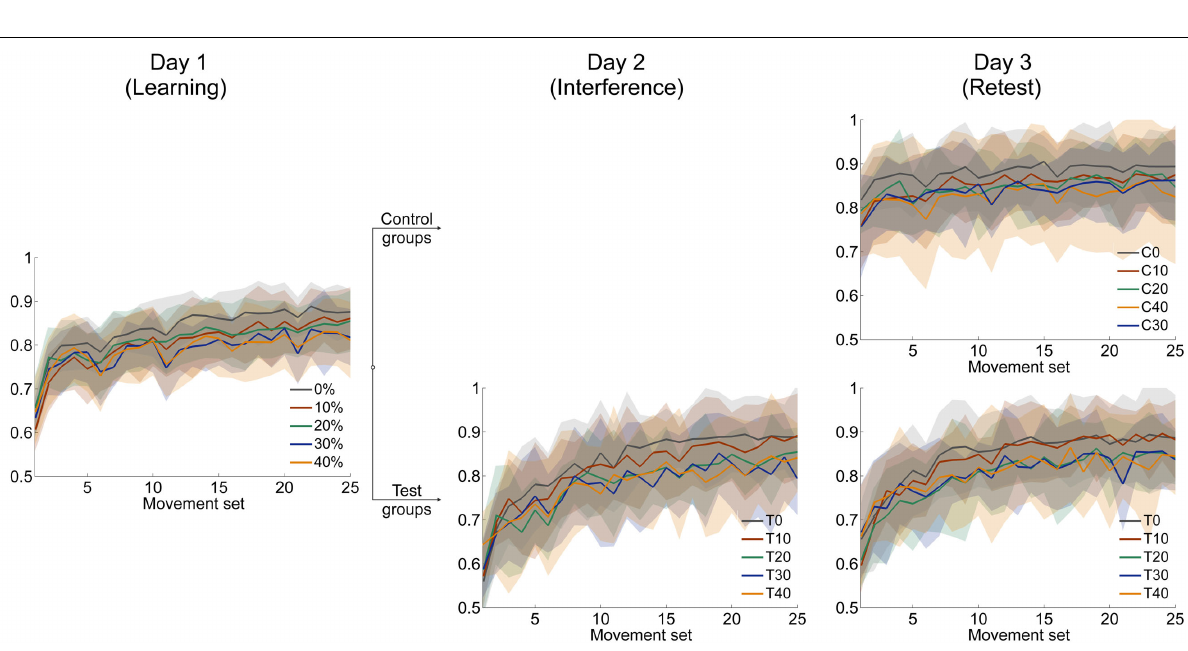
groups were retested in force field A (right) . On all three days, subjects were able to adapt to the changed dynamic conditions indicated by increasing correlation coefficients. All data is presented as mean values ± 95% confidence